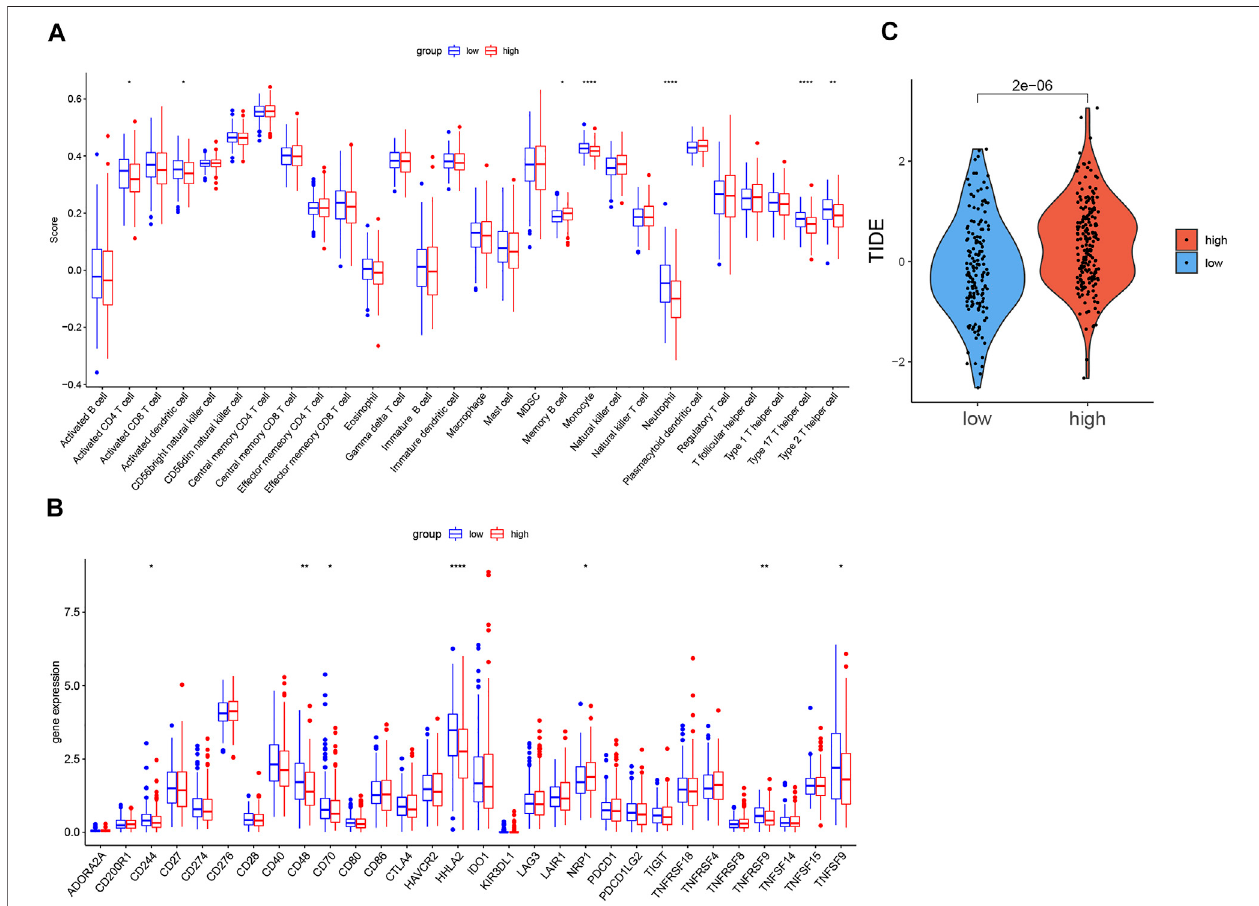
FIGURE 7 | Comparison of immune in fi ltration, expression level of immune checkpoints, TIDE score in two groups. (A). Boxplot of the difference of immune in fi ltrationcellsinhigh-andlow-riskgroups; (B). Boxplotoftheexpressionlevelofimmunecheckpointinhigh-andlow-riskgroups. (C). BoxplotoftheTIDEscoreinhigh- and low-risk groups ( p < 0.05 *, p < 0.01 **, p < 0.001 ***, p < 0.0001 ****).